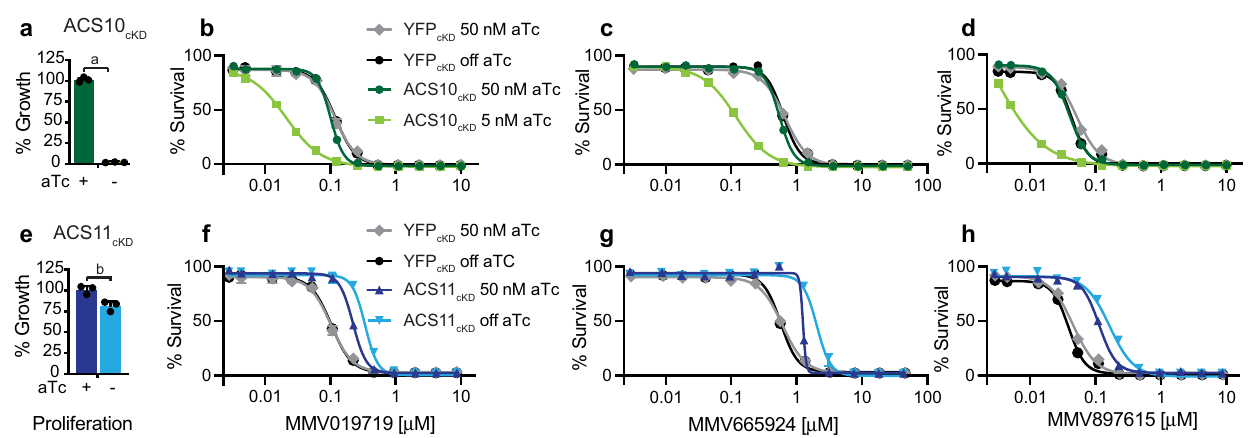
Fig. 5 | Knockdown of Pf ACS10 leads to hypersensitivity to pro fi led inhibitors. Theconditionalknockdownlinefor Pf ACS10wasgeneratedwiththeTetR-aptamer system, similar to the previously generated ACS11cKD and YFP cKD lines 40 . Viability of the lines was tested by removing anhydrotetracycline (aTc) and measuring parasite proliferation by luminescence of the luciferase reporter gene after 72h. a Lossof Pf ACS10resultedinacompleteblockofgrowth,whereas e lossof Pf ACS11 resulted in a 20% growth reduction. Shown is one biological replicate run in tri- plicate. Tests for signi fi cance used a two-sided unpaired Student ’ s t test: a: p =0.0000005,b: p =0.012.Exampleofdoseresponsecurvesfor b , f MMV019719, c , g MMV665924,and d , h